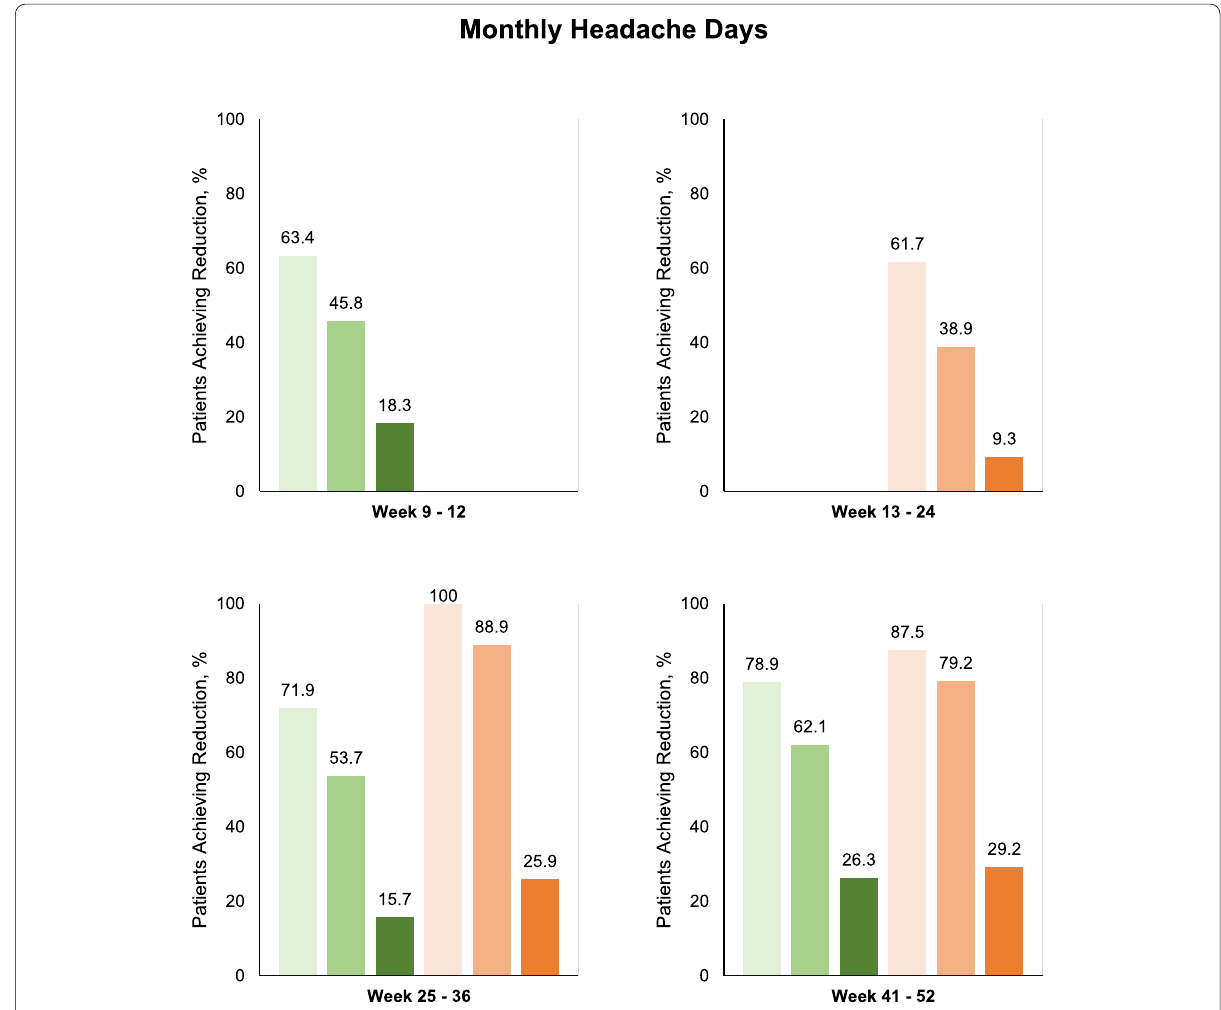
Fig. 3 Proportion of patients With 30%, 50%, and 75% reduction in number of monthly headache days of any severity. Green represents ≥ ≥ ≥ patients treated with 140‑mg erenumab, light: 30%, medium: 50%, and dark: 75%. Orange represents patients treated with 70‑mg erenumab, ≥ ≥ ≥ light: 30%, medium: 50%, and dark: 75%. Participants with data available for analysis; Weeks 9–12, n ≥ ≥ ≥ 140‑mg, n 121; 70‑mg, n 27; Weeks 41–52; 140‑mg, n 95; 70‑mg, n = = = =